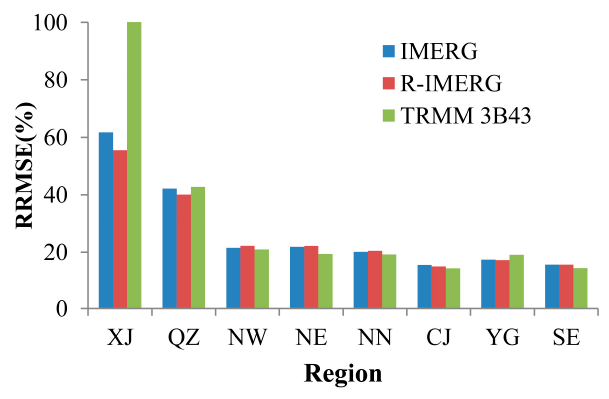
Figure 4. RRMSE values of annual precipitation estimates derived from IMERG, R-IMERG, and TRMM 3B43 products over the eight sub-regions.